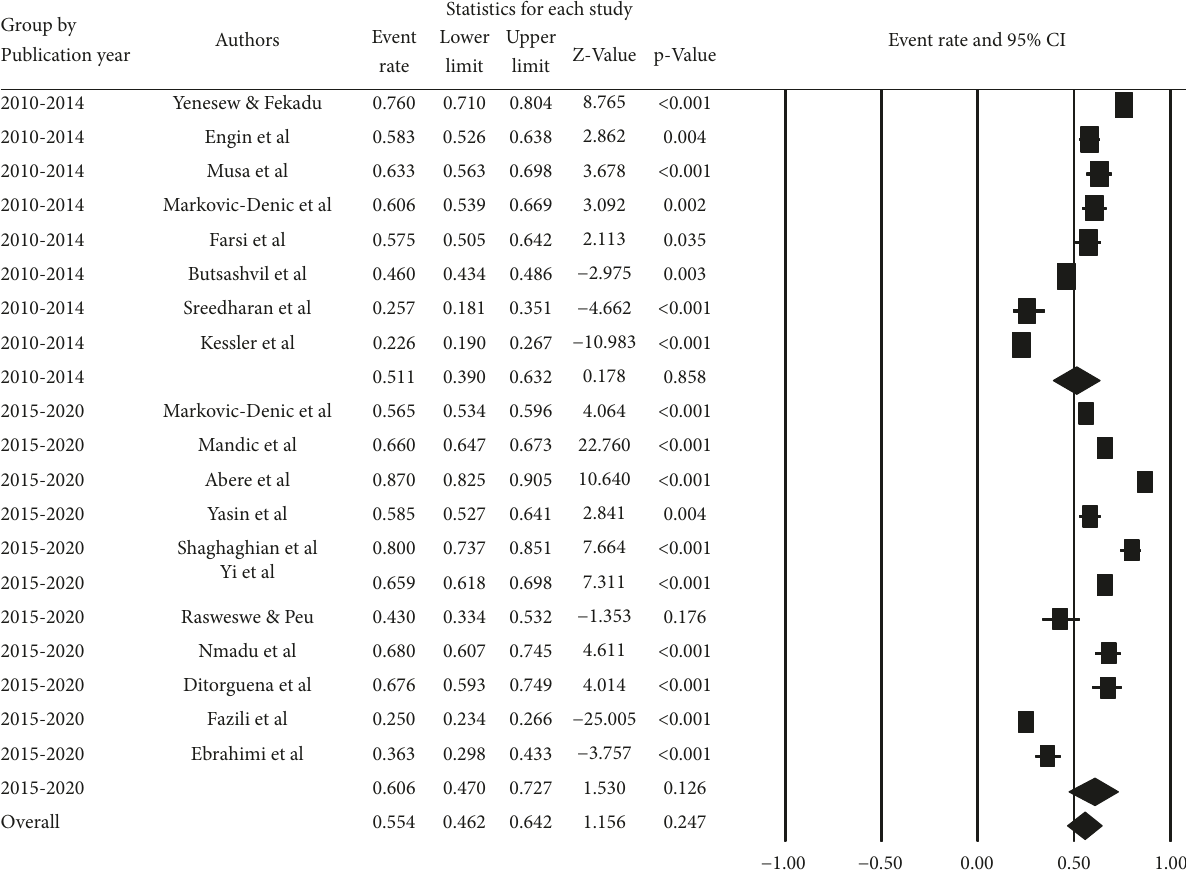
Figure 7: Pooled prevalence of occupational exposure to blood and body fluids in career time among healthcare workers based on the publication